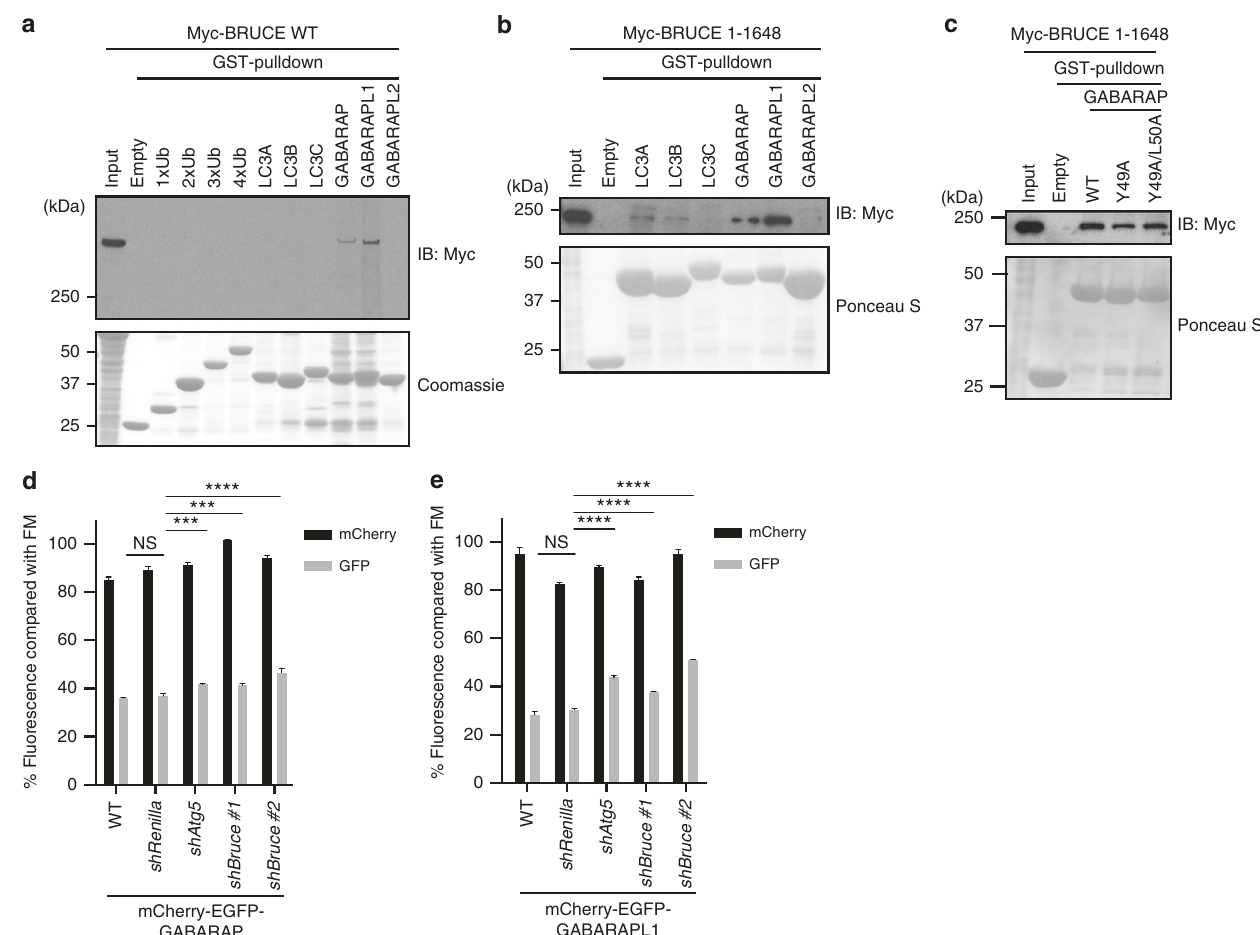
Fig. 3 BRUCE interacts speci fi cally with GABARAP and GABARAPL1. a , b Interaction of BRUCE wild type (WT) or aa 1 – 1648 fragment and mammalian ATG8 proteins and ubiquitins examined by GST pull-down assay. Total cell lysate of HEK293T cells transfected with Myc-tagged WT or the 1 – 1648 fragment was incubated with GST-ubiquitin or GST-ATG8 proteins immobilized with glutathione sepharose beads. Interaction was detected by immunoblotting using anti-Myc antibody. The amount of GST-protein used was compared by Coomassie or Ponceau S staining. c Interaction of BRUCE 1 – 1648 and GABARAP WT or mutants examined by GST pull-down assay. GABARAP mutants contained substitutions in the canonical LC3-interacting region (LIR) recognition surface (Y49A and Y49A/L50A). d , e Normalized mCherry/GFP signals under starvation condition normalized to FM condition in MEF lines stably expressing mCherry-EGFP-GABARAP d or mCherry-EGFP-GABARAPL1 e . Control (WT and shRenilla ) and KD ( shAtg5 and shBruce#1 and #2 ) cells were starved for 6 h. Data are presented as mean ± SD from three biological replicates (**** p < 0.0001, *** p < 0.001, NS, not signi fi